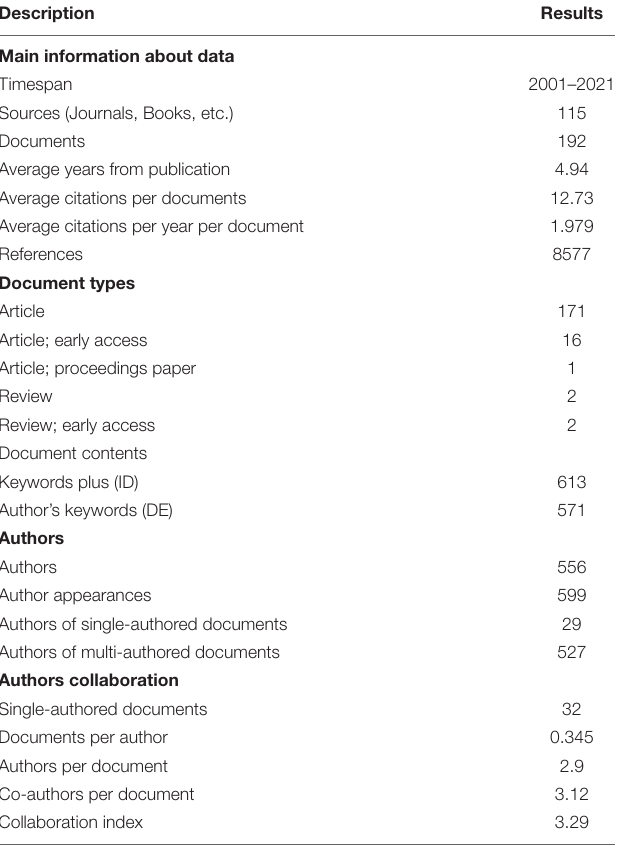
TABLE 1 | Key details of extracted documents by WoS for bibliometric